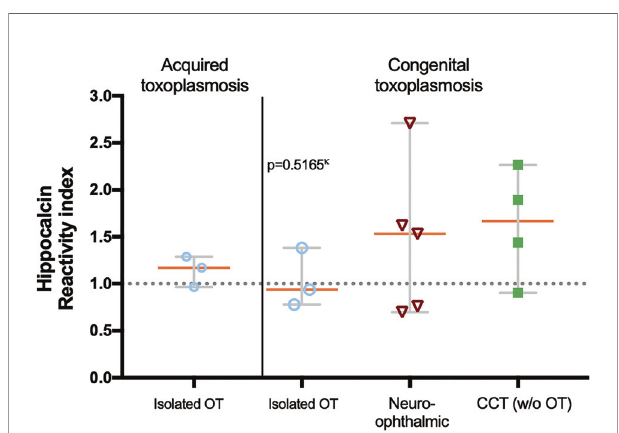
FIGURE 7 | Presence of anti-hippocalcin autoantibodies in the different clinical groups. The graph shows the hippocalcin reactivity of the selected samples and the proportion of positives, i.e. RI ≥ 1.0. Statistics performed with Kruskal-Wallis.